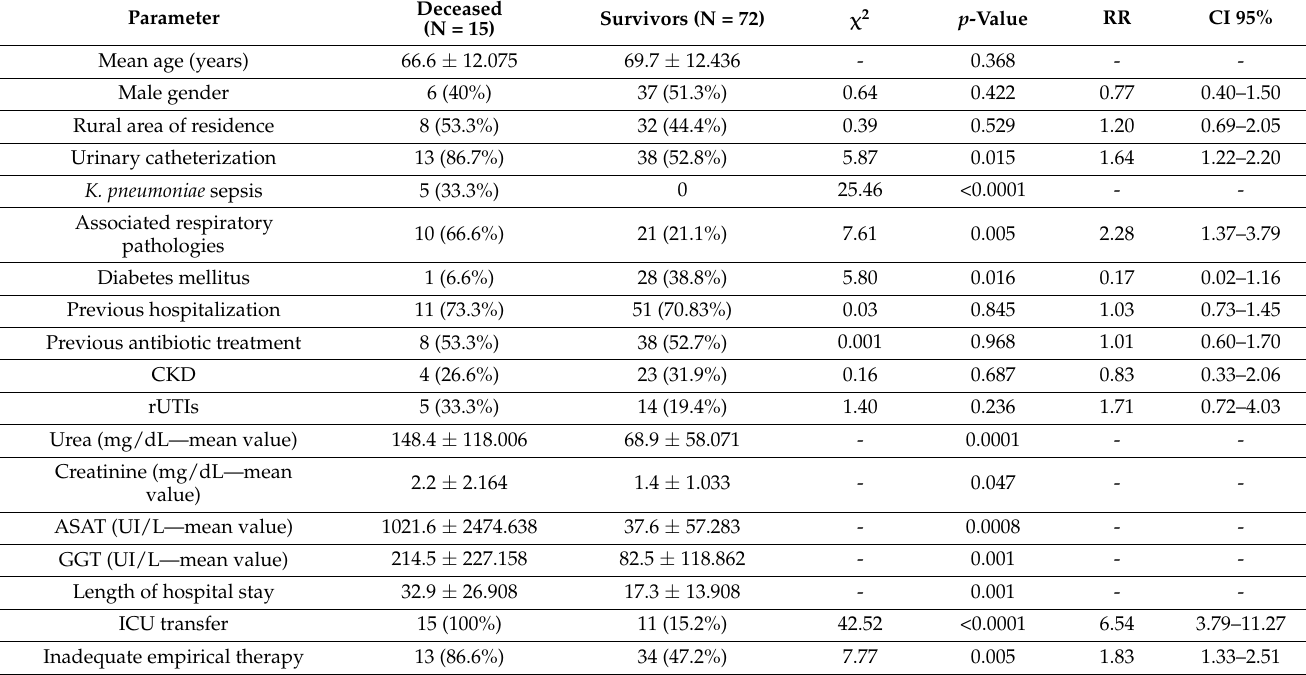
Table 4. Additional risk factors associated with